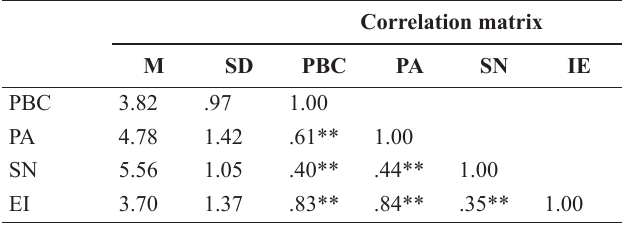
Table 2 . Mean (M), Standard Deviation (SD), and Correlation Matrix.